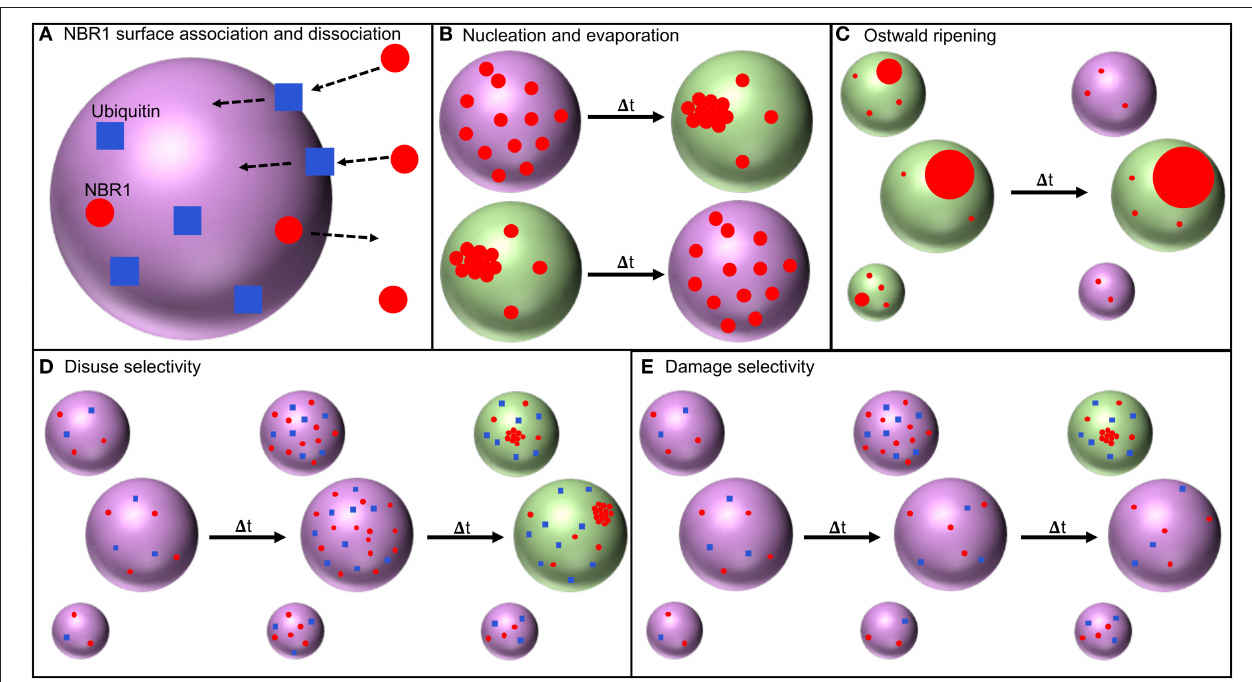
FIGURE 1 | Model processes. (A) NBR1 (red circles) in the cytosol surrounding a peroxisome (large purple sphere) associates with the peroxisome membrane via transient association with ubiquitin (blue squares) bound to the peroxisome membrane (association rate in Equation 2). NBR1 on the peroxisome membrane can then dissociate from the peroxisome membrane (dissociation rate in Equation 4). (B) With sufficient NBR1 present on the peroxisome membrane, a cluster of NBR1 nucleates (required concentration in Equation 10). The number of NBR1 in a cluster can increase or decrease following nucleation (Equation 1). Peroxisomes colored green harbor an NBR1 cluster and may be selected for degradation by autophagy. (C) Ostwald ripening results in the growth of larger clusters, and shrinking and evaporation of smaller clusters (Equation 1 describes cluster size dynamics). (D) Under “disuse” conditions that cause the number of ubiquitin on all peroxisomes to increase, more NBR1 will associate with peroxisome membrane, facilitating cluster nucleation, and the selection of larger peroxisomes for degradation by autophagy. (E) Damage may cause the number of ubiquitin on a subset of peroxisomes to increase, leading to increased NBR1 association on those peroxisomes, possible cluster nucleation, and selection of those damaged peroxisomes for degradation by